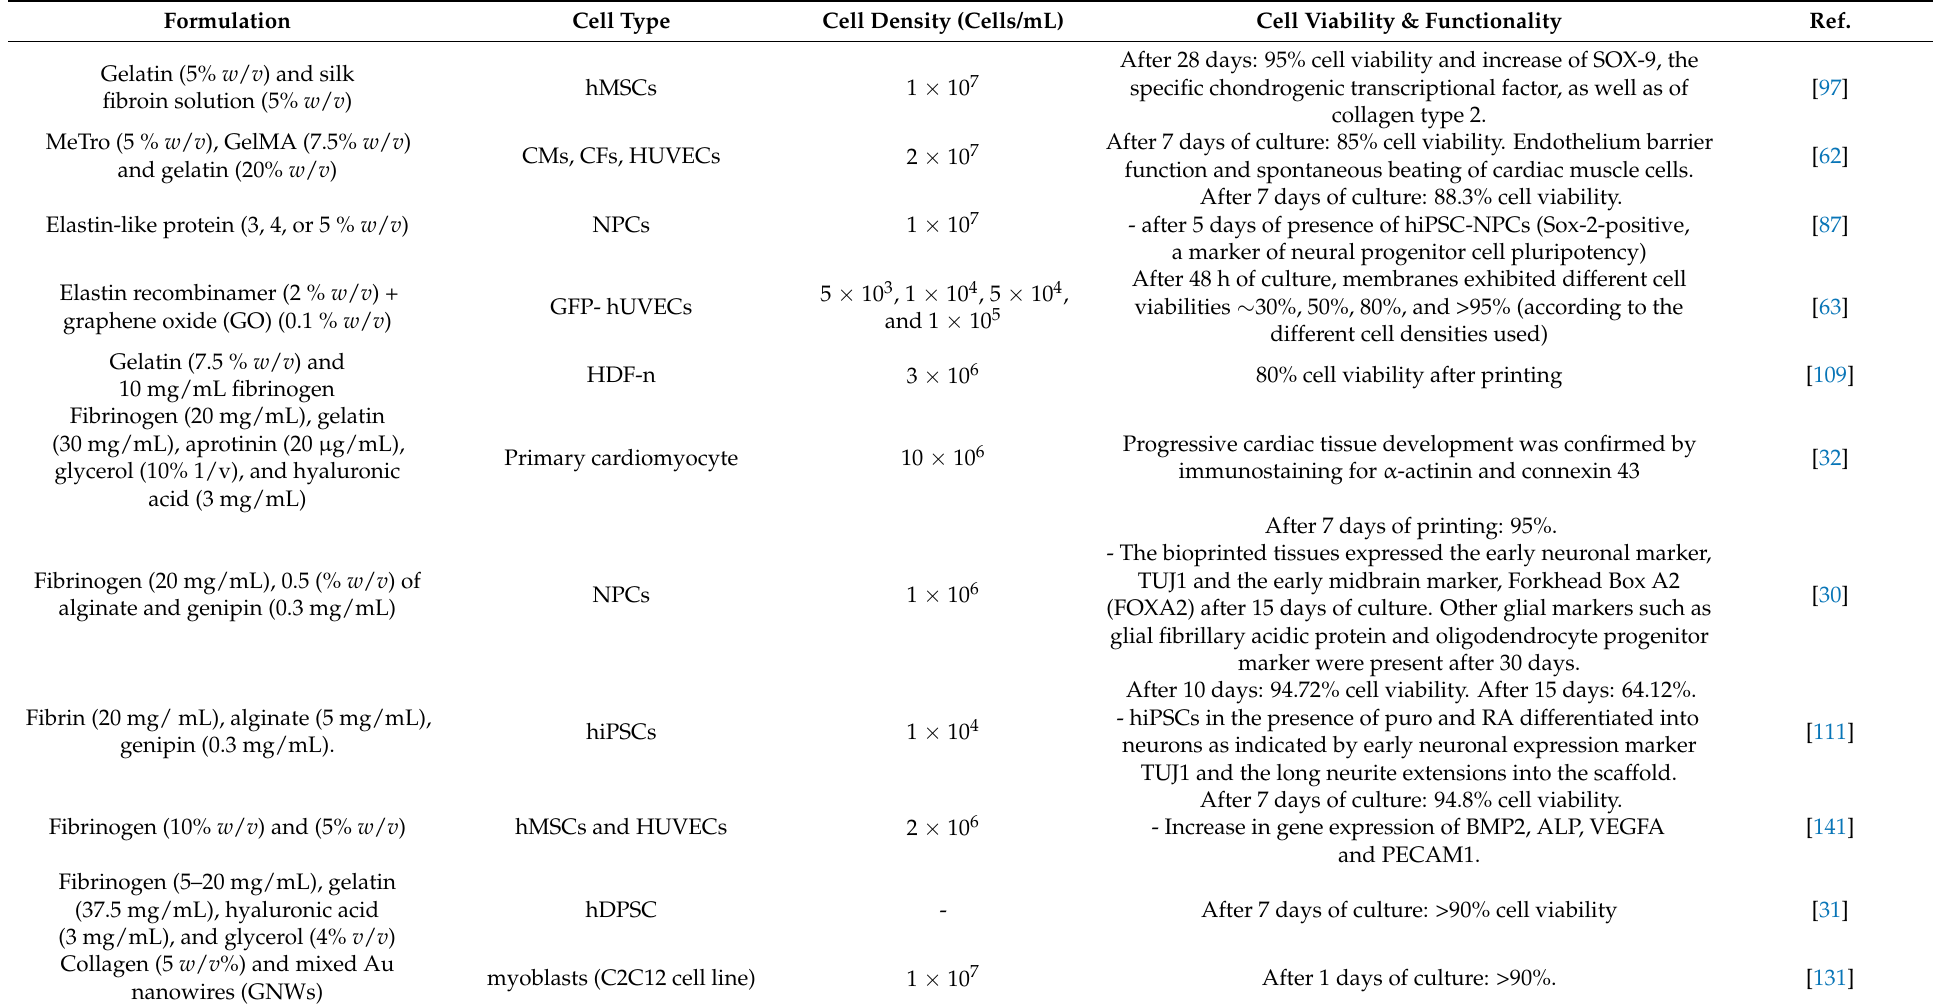
Table 4. Overview of the application of cell embedding in 3D bio-printed